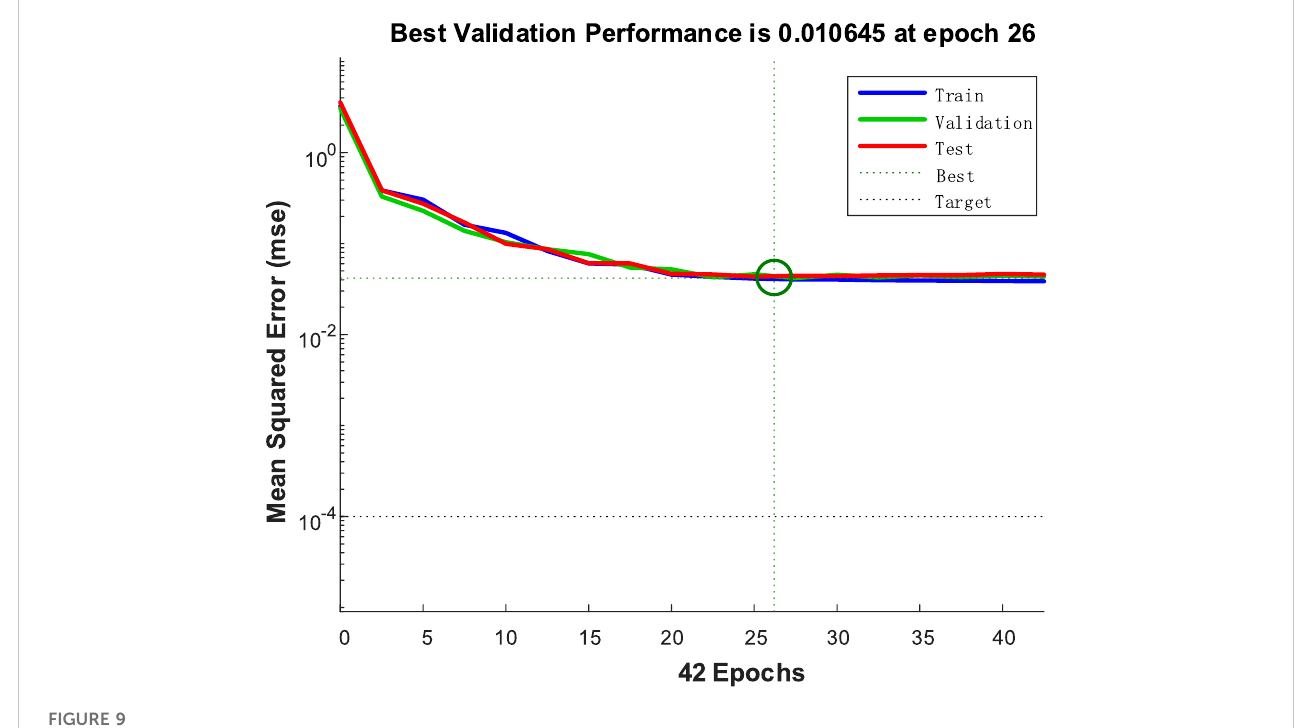
FIGURE 9 The training error of Traditional BP neural network.